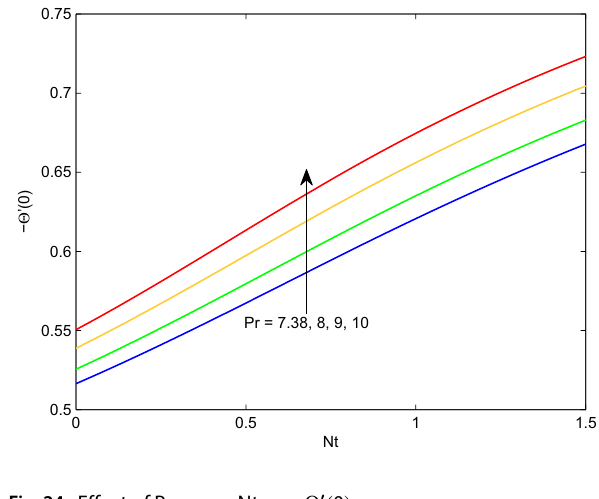
Fig. 24 Effect of Pr versus Nt on −Θ � ( 0